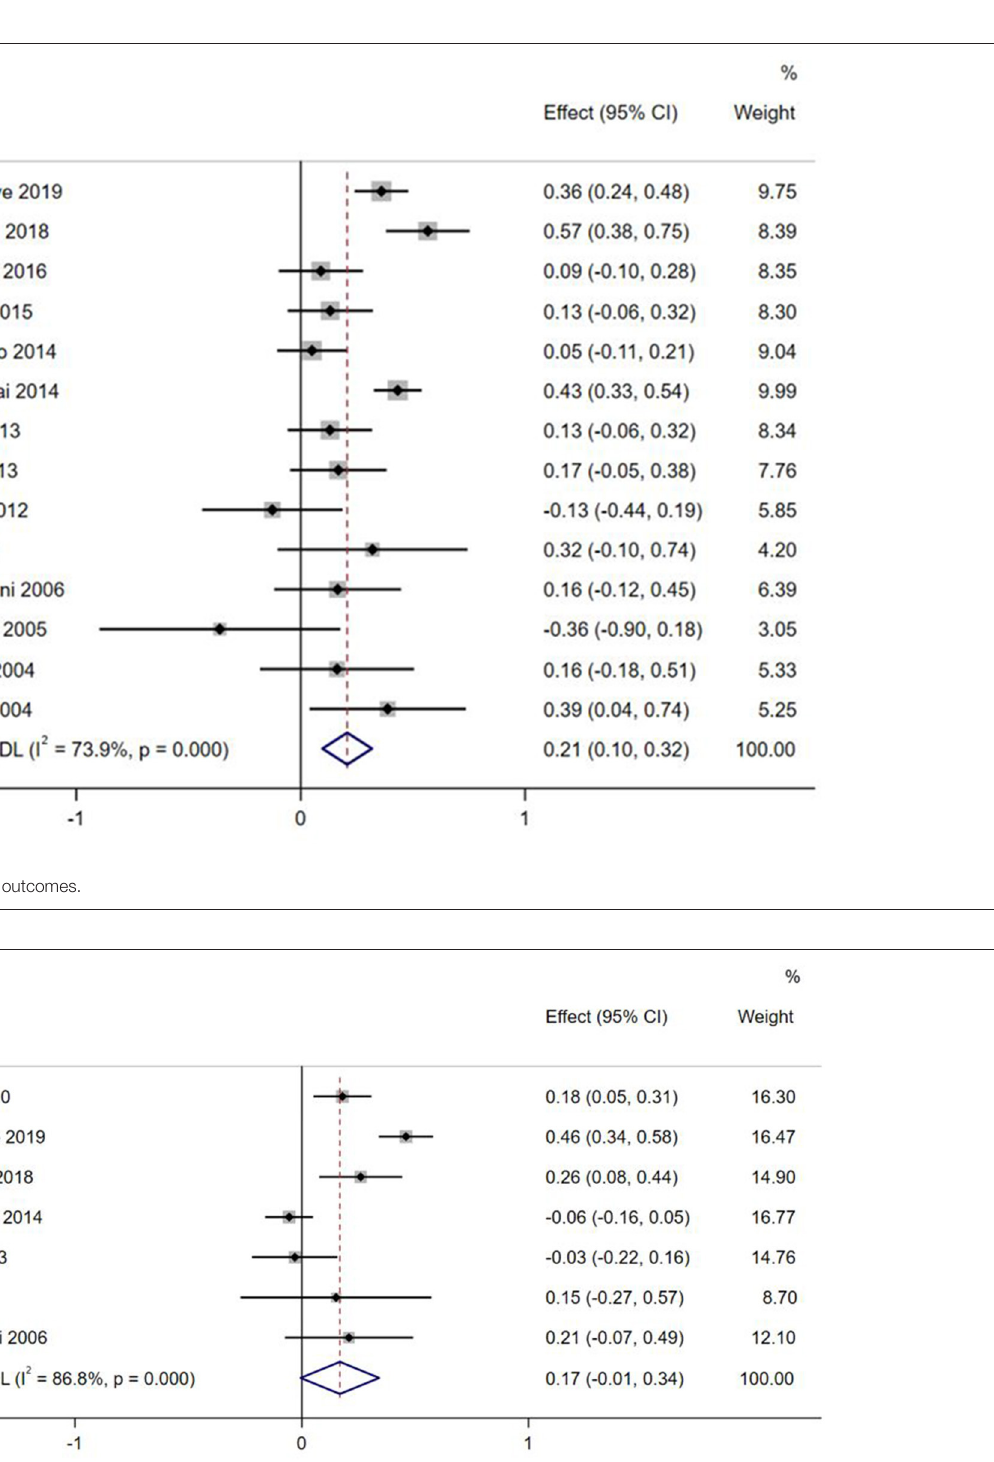
FIGURE 5 | Effect sizes on Socio-emotional outcomes.